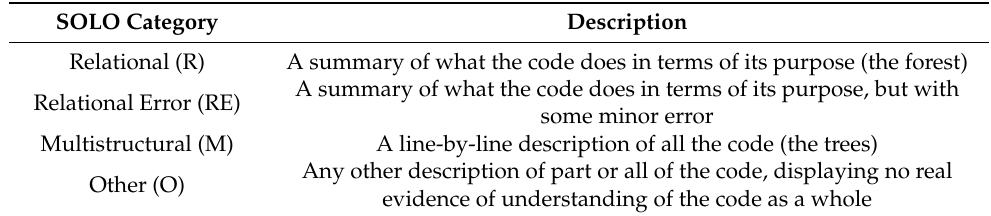
Table 1. SOLO categories for program comprehension